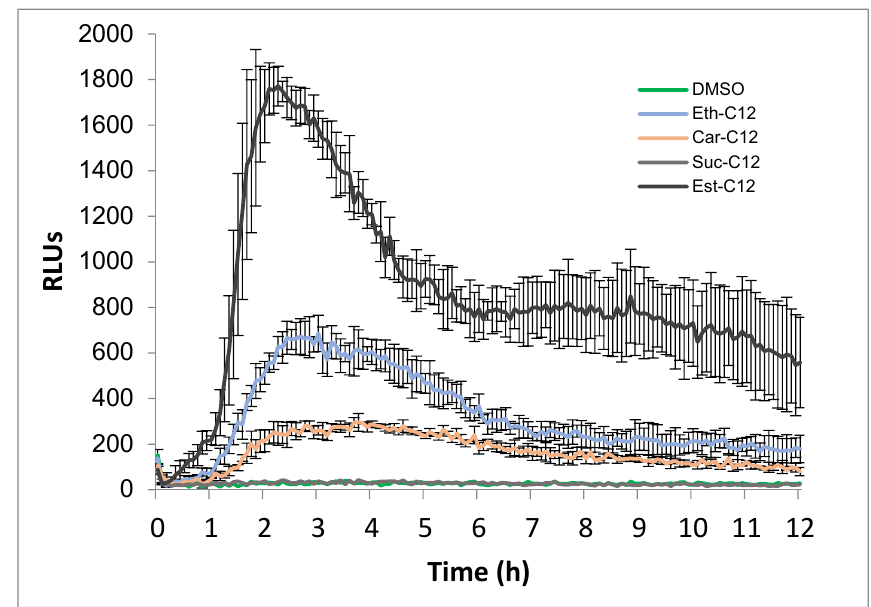
Figure 2. ROS production after smRLs treatment of tomato leaf disks. smRLs with carbamate (Car), succinate (Suc), ester (Est) or ether (Eth) links between the rhamnose and the acyl chain or DMSO (0.1%) control were used in these experiments. Reactive oxygen species (ROS) production was measured using the chemiluminescence of luminol and photon counts were expressed as relative luminescence units (RLUs).